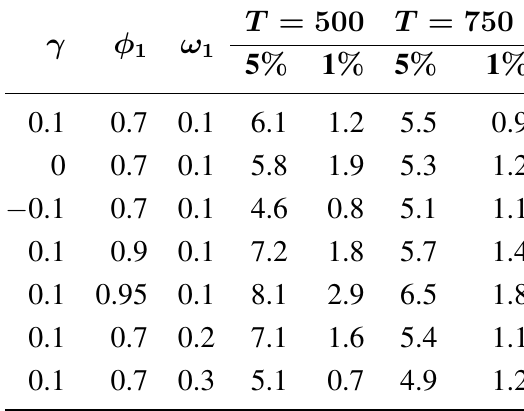
Table 1. Empirical size of the LM test by Monte Carlo experiments.